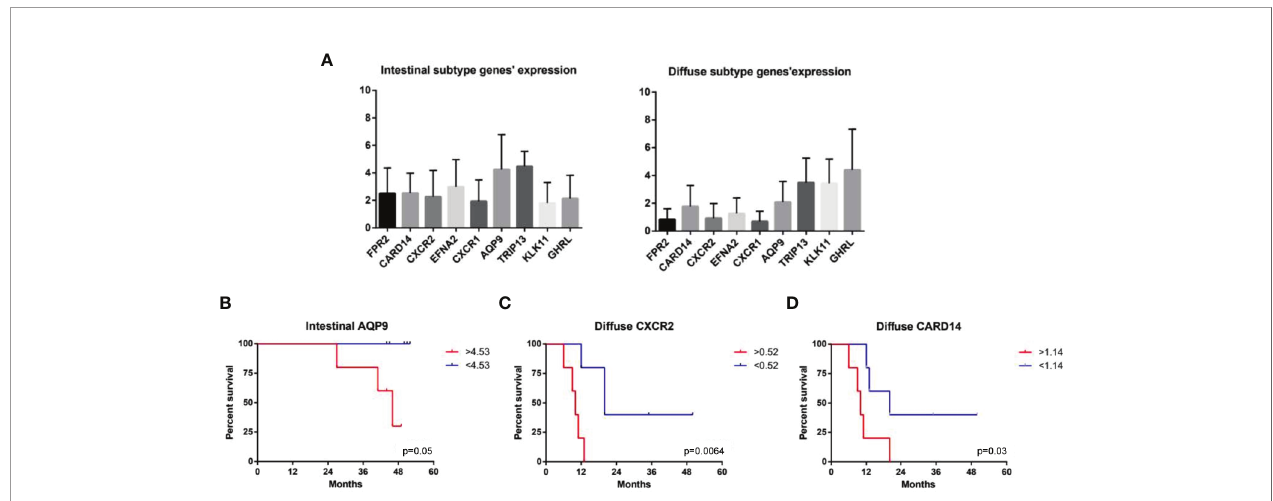
FIGURE 8 | Impact of gene expression in overall survival. (A) Patients were dichotomized into two groups according to the median value of expression each gene. (B) Impact of AQP9 gene expression on patient survival in the intestinal group. Impact of (C) CXCR2 and (D) CARD14 on patient survival in the diffuse group (p <